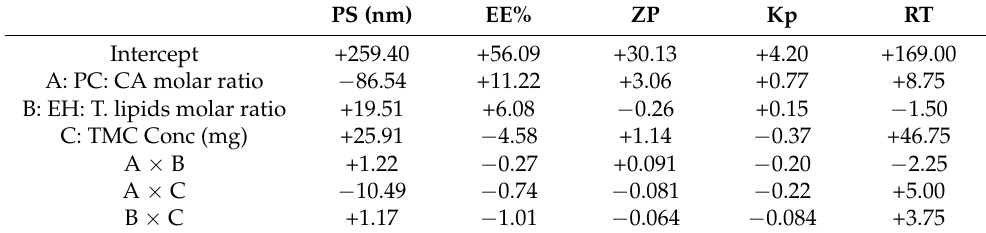
Table 4. Final equation in terms of the tested